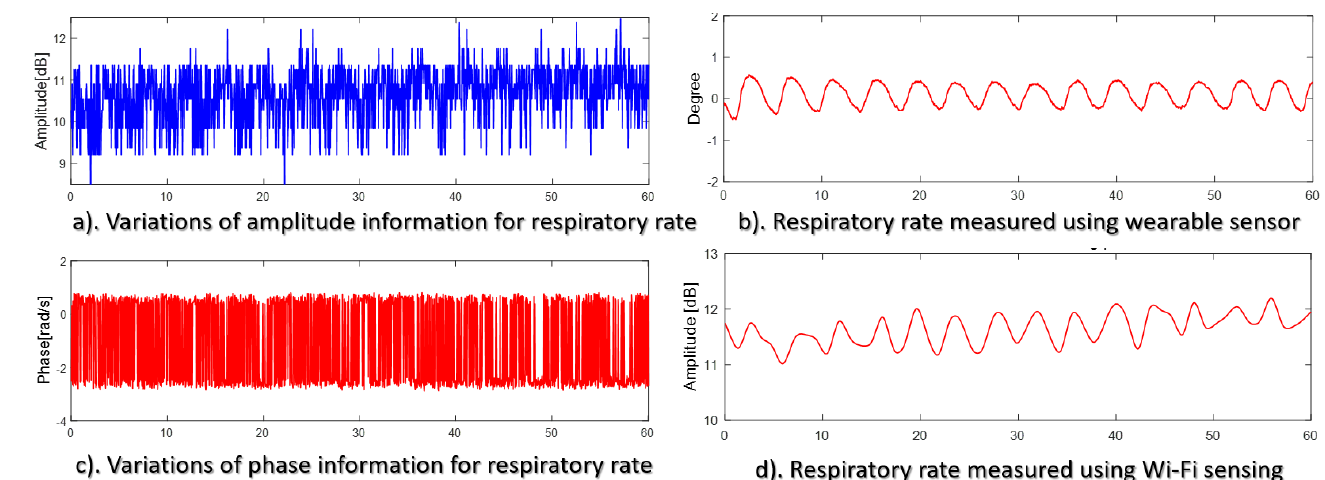
Figure 4. Respiratory-rate measured using WiFi sensing and compared with a wearable sensor.